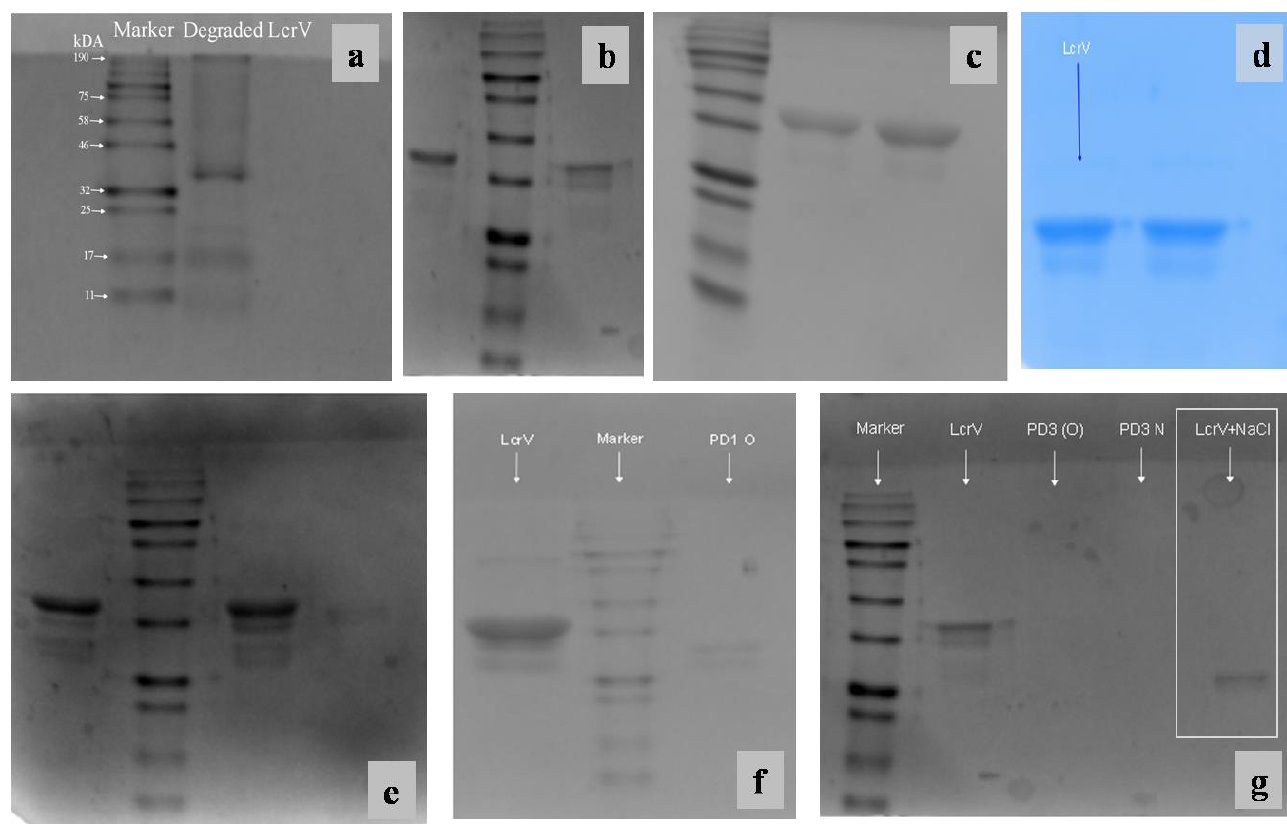
Figure 6. SDS-PAGE analysis of LcrV and PD1 formulations stored at room temperature (30 ± 2 ◦